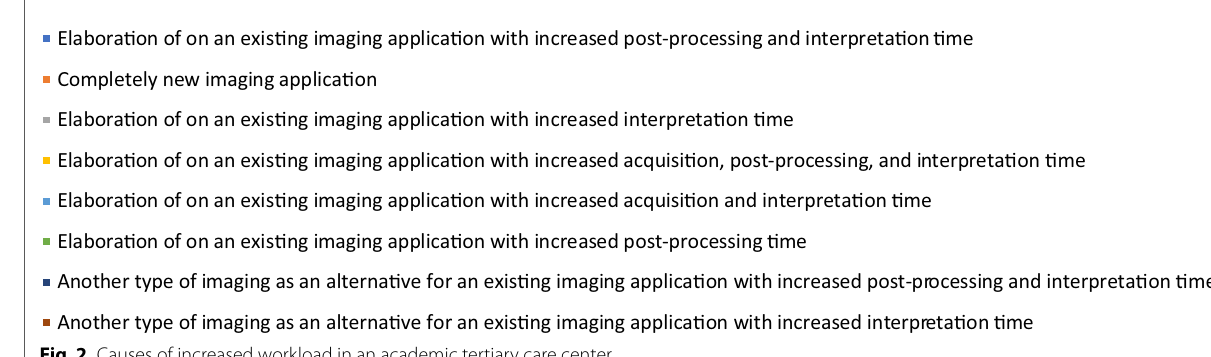
Fig. 2 Causes of increased workload in an academic tertiary care